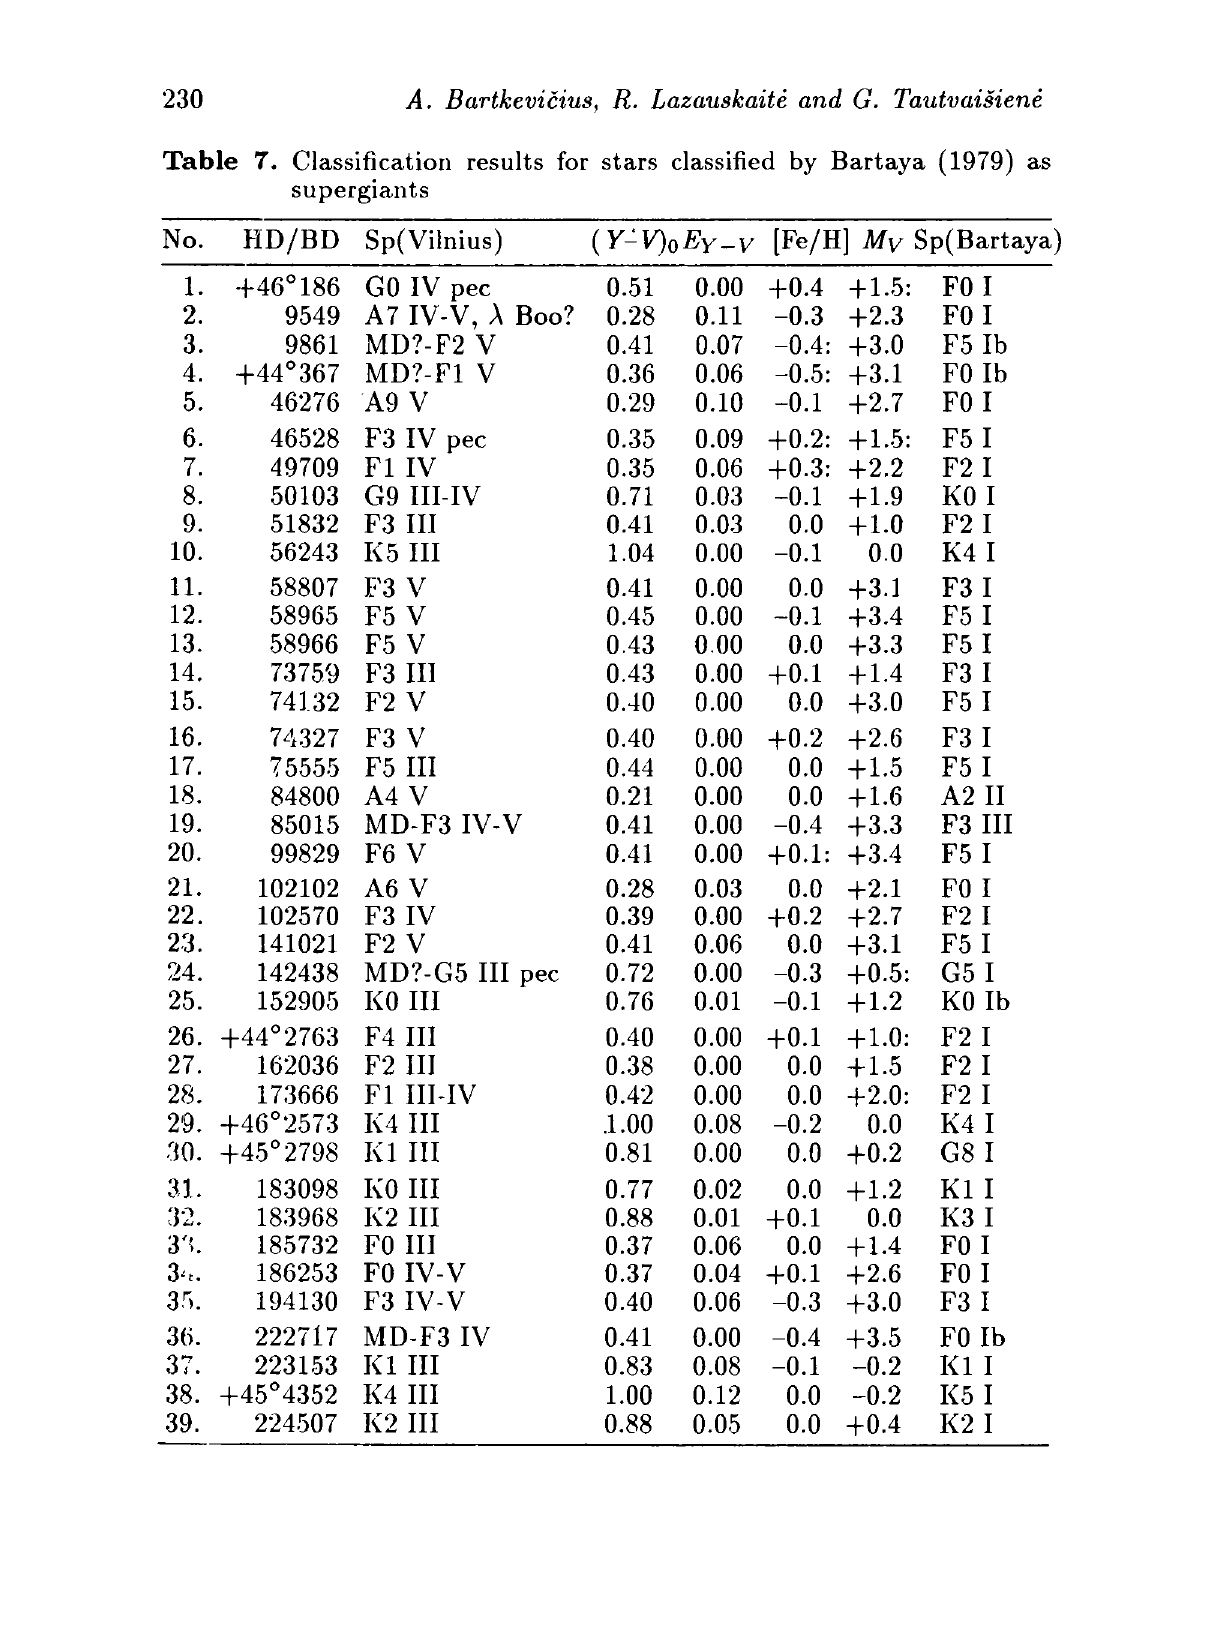
Table 7. Classification results for stars classified by Bartaya (1979)